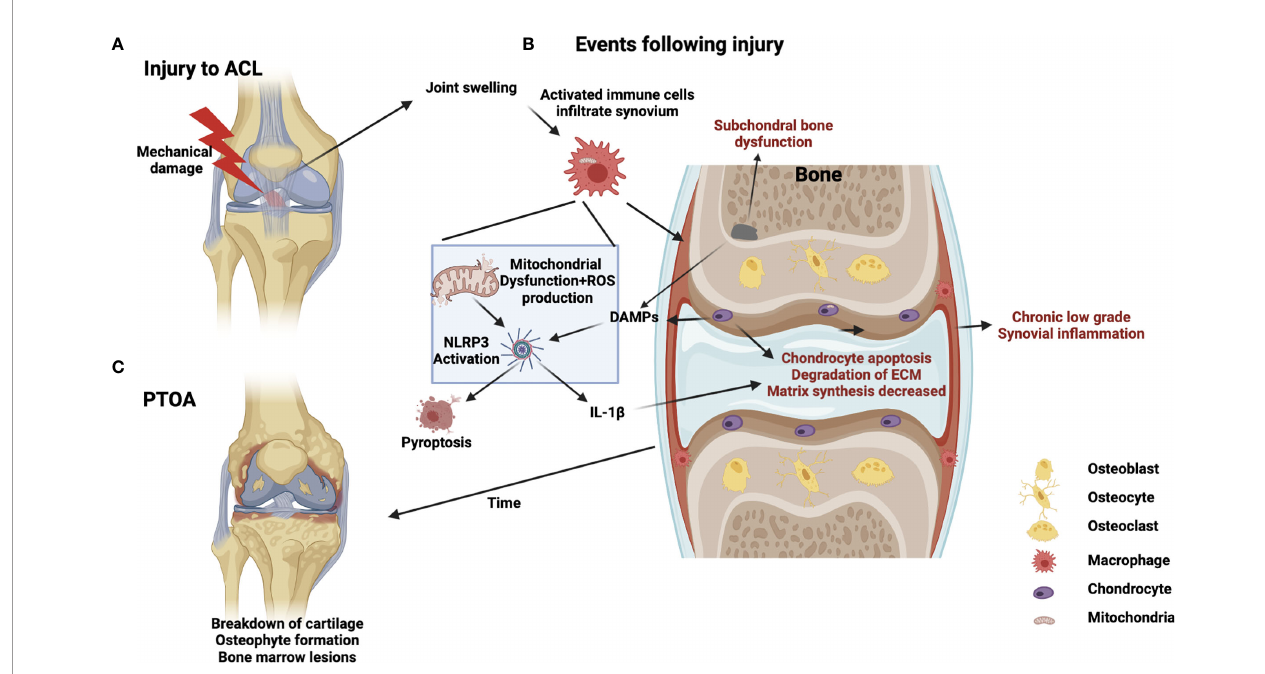
FIGURE 1 | Schematic of PTOA progression illustrating potential mitochondrial involvement in injury, in fl ammation, and disease. (A) Acute injury, such as ACL rupture, results in joint swelling and in fi ltration of immune cells. (B) Crosstalk between immune cells, chondrocytes and subchondral bone cells occurs involving DAMPS, PRRs, mechanotransduction, NLRP3 activation, cell-death/pyroptosis, mitochondrial dysfunction, cytokine release and ROS production from immune cells generating a feed-forward loop to drive chronic in fl ammation, matrix degradation and subchondral bone dysfunction (C) Chronic development of PTOA, long-term low-grade in fl ammation, bone marrow lesions and cartilage